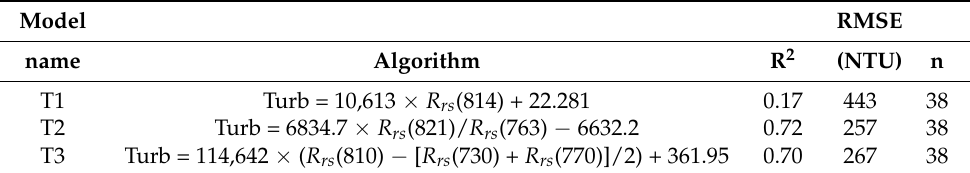
Table 6. Optimal turbidity algorithm using the T1, T2 and T3 models.